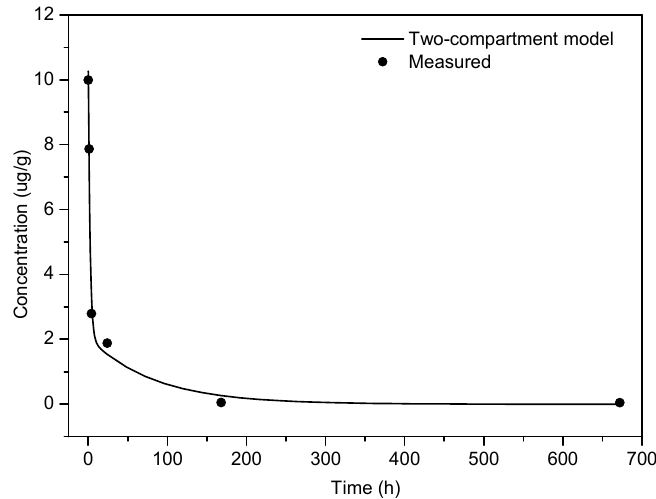
Figure 2. Time course of PEG-AuNPs blood concentration after a single dose i.v. administration (mean dose 160.5 µ g). The solid line corresponds to the least-squares fit by the two-compartment model. Table 3. Pharmacokinetic parameters obtained from the two-compartment model fitted to PEG- AuNPs concentration in the blood. The values of corresponding composite parameters